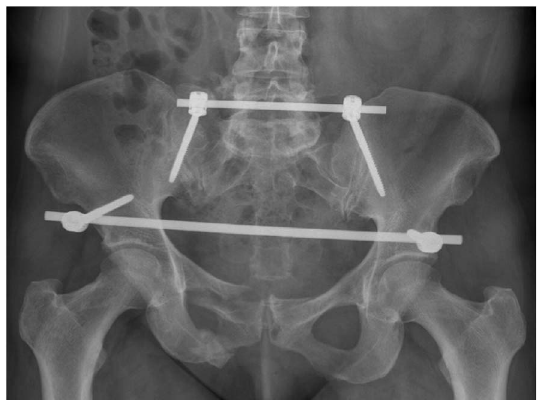
Figure 3. Postoperative plain radiograph demonstrated complete pelvic ring fracture at the right side with a sacral fracture treated with a TIFI and an anterior internal fi